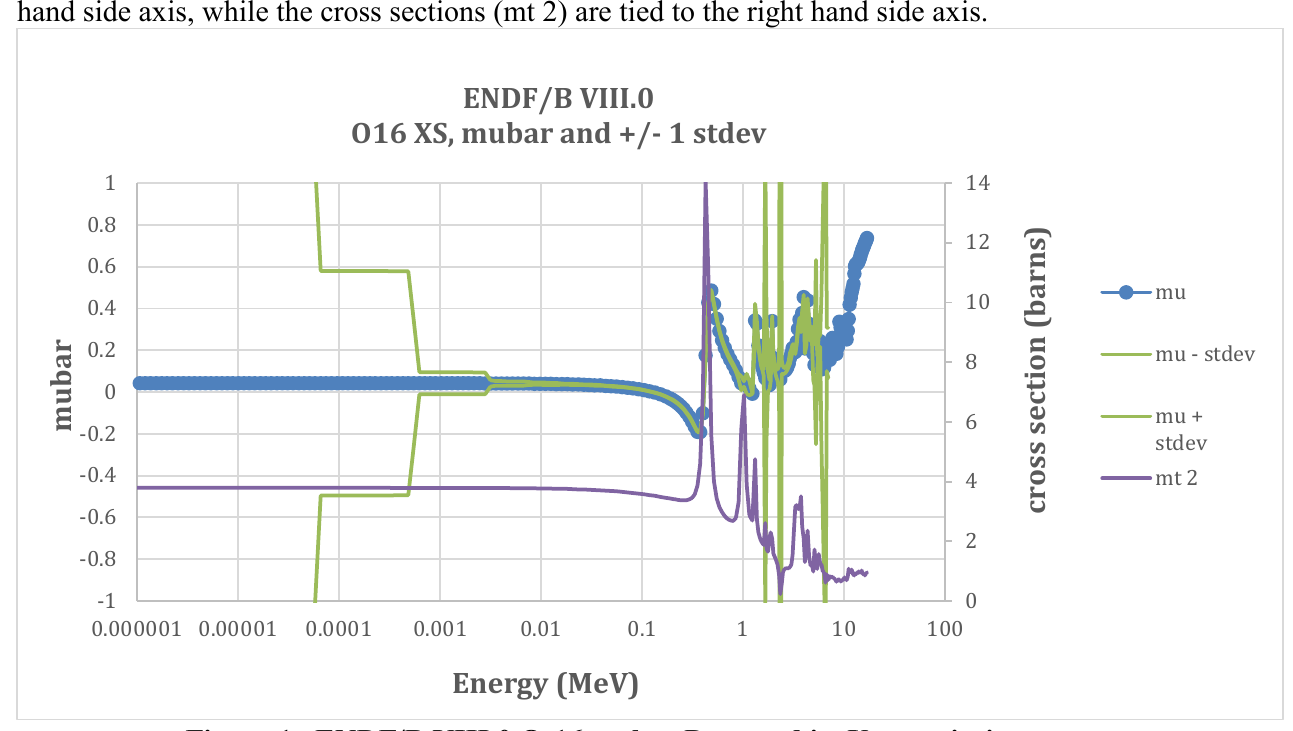
Figure 1. ENDF/B VIII.0 O-16 mubar Data and its